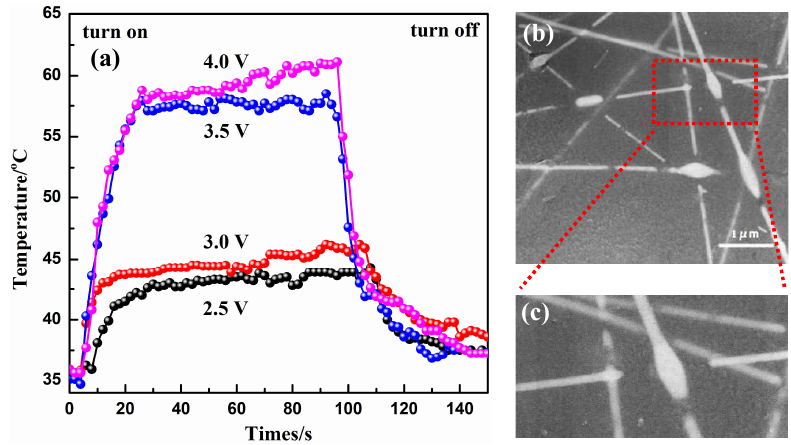
Figure 5. ( a ) Evolution of generated temperature of the Ag NWs-PI film with transmittance of 53% at various voltages from 2.5 to 4 V; ( b ) SEM image of the composite film after heating at a high voltage; ( c ) magnified SEM image of red rectangle area in ( b (c) magnified SEM image of red rectangle area in (b). 240